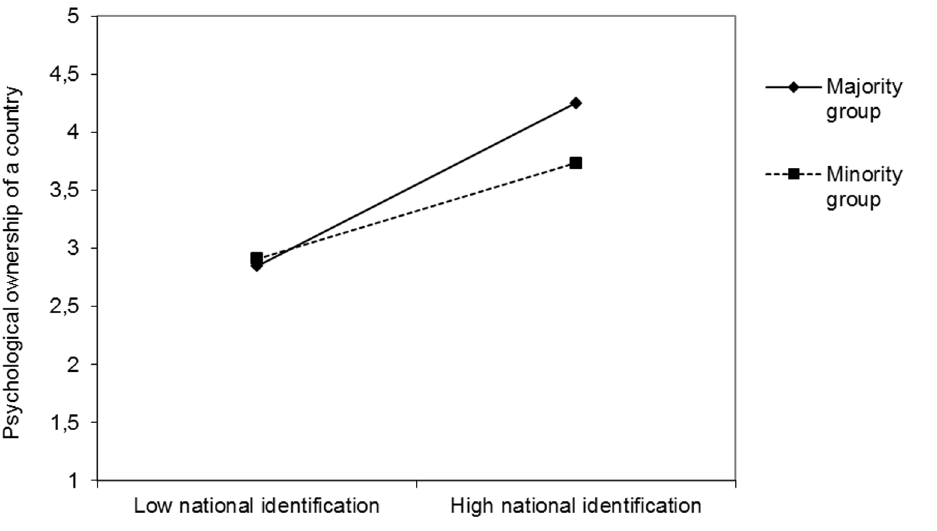
Figure 3. The moderating effect of group status (majority vs. minority) on the relationship between national identification and psychological ownership of a